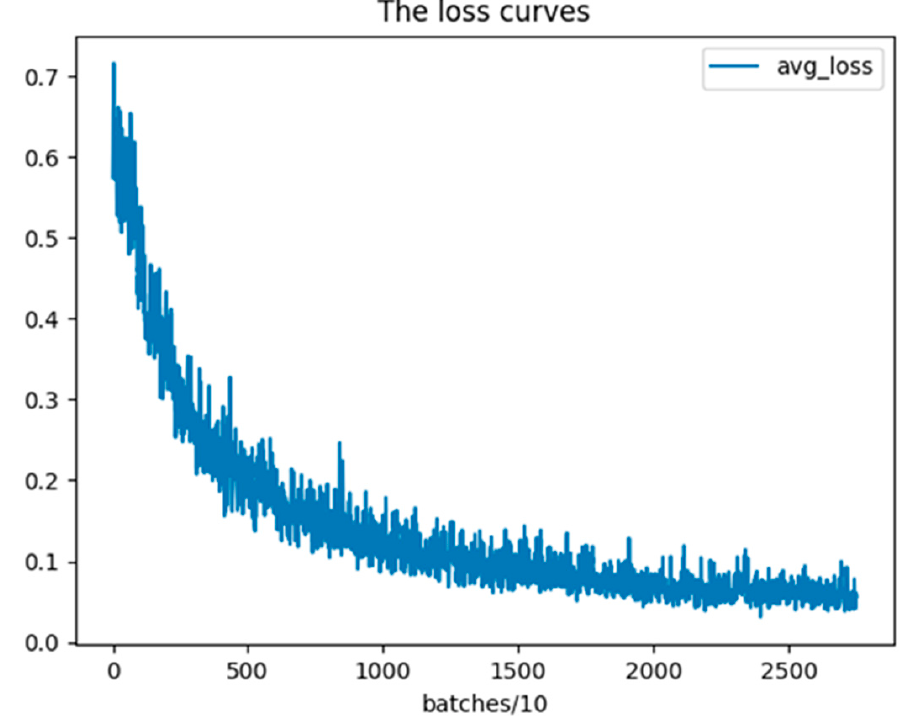
Figure 6. DSPP-YOLO loss function.